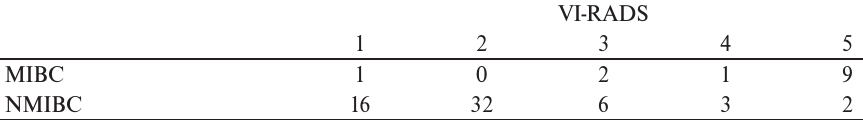
Table 3. The evaluation of the diagnostic accuracy of the VI-RADS system.